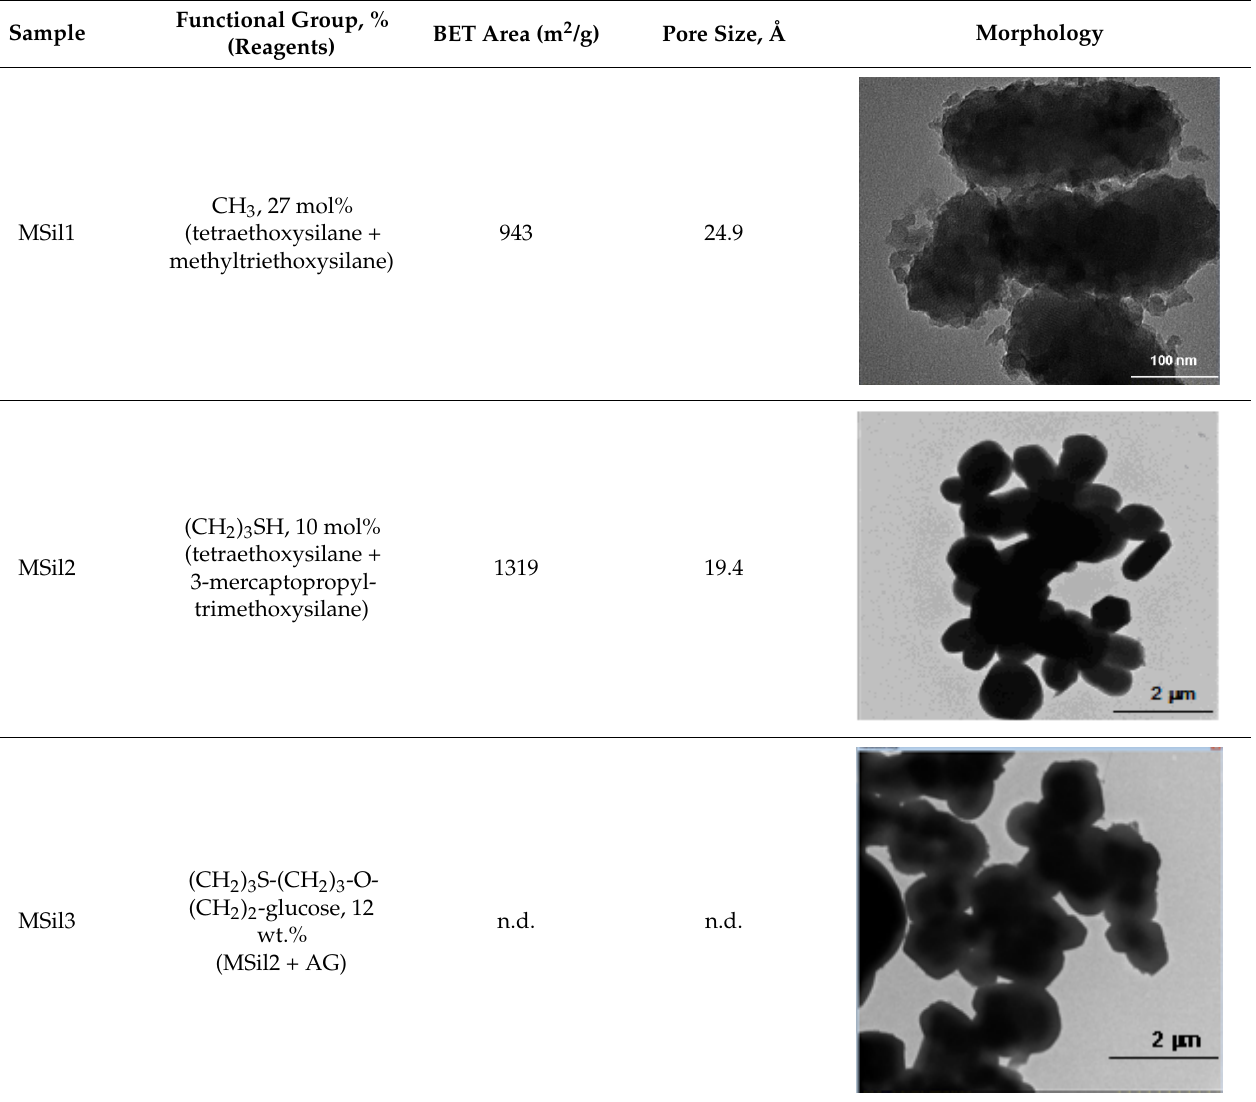
Table 1. Characteristics of mesoporous silica materials.